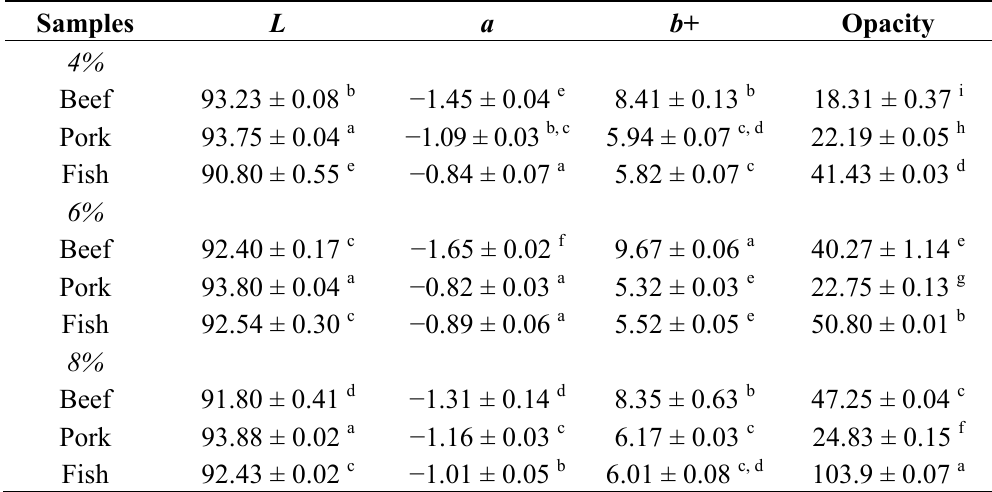
Table 2. Colour properties and opacity of gelatin